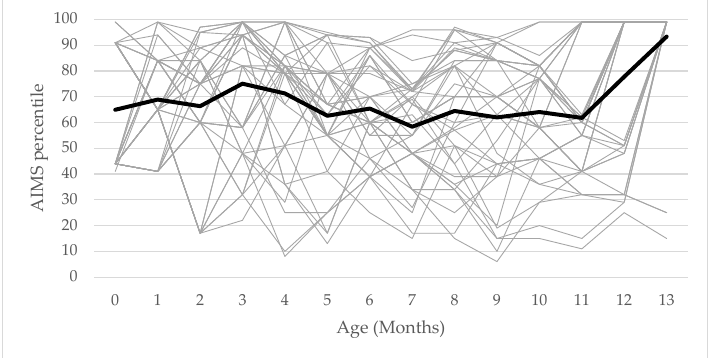
Figure 1. The up and down with a non-systematic pattern of gross motor percentile rank for the 41 participants. The gray lines show individual participants’ gross motor percentile. The darkest line shows the mean values of each month’s percentiles.